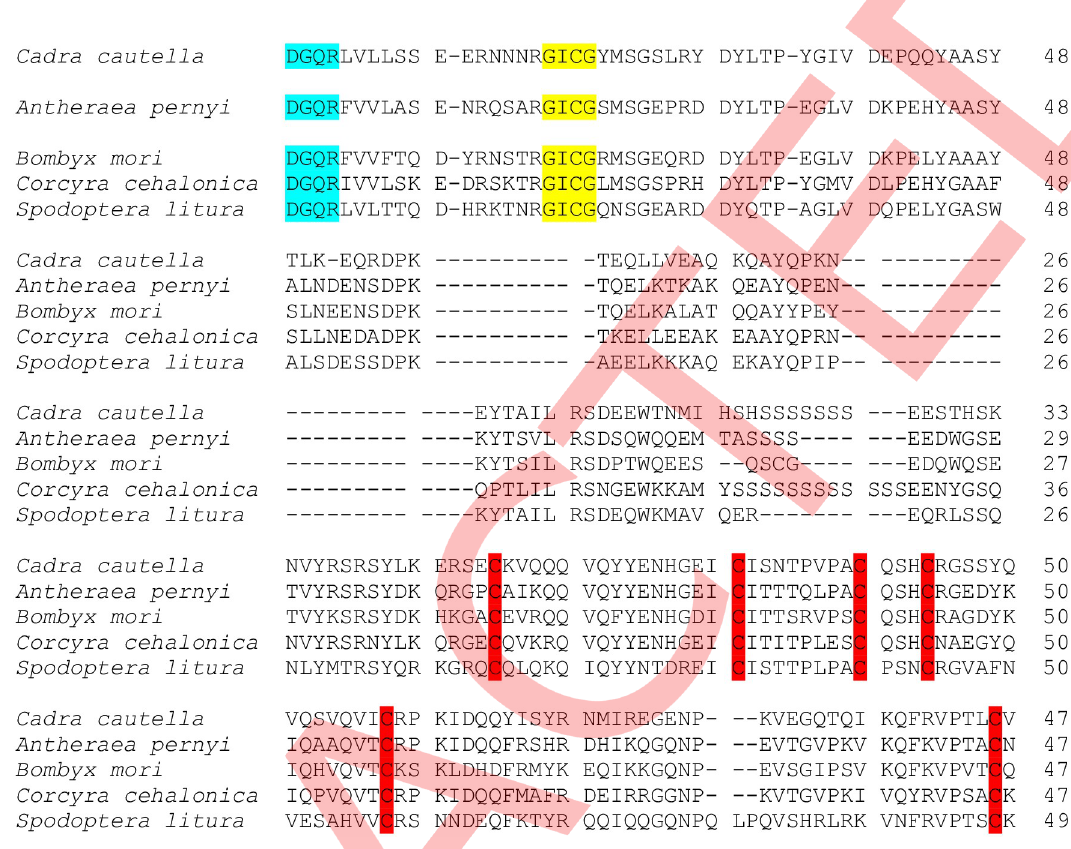
Fig 2. Structural comparison of Cadra cautella Vg C-terminus with other lepidopteran members. Clustal W multiple alignment program was used. The conserved DGXR, GL/ICG motifs, and cysteine (C) residue are with bright colors.